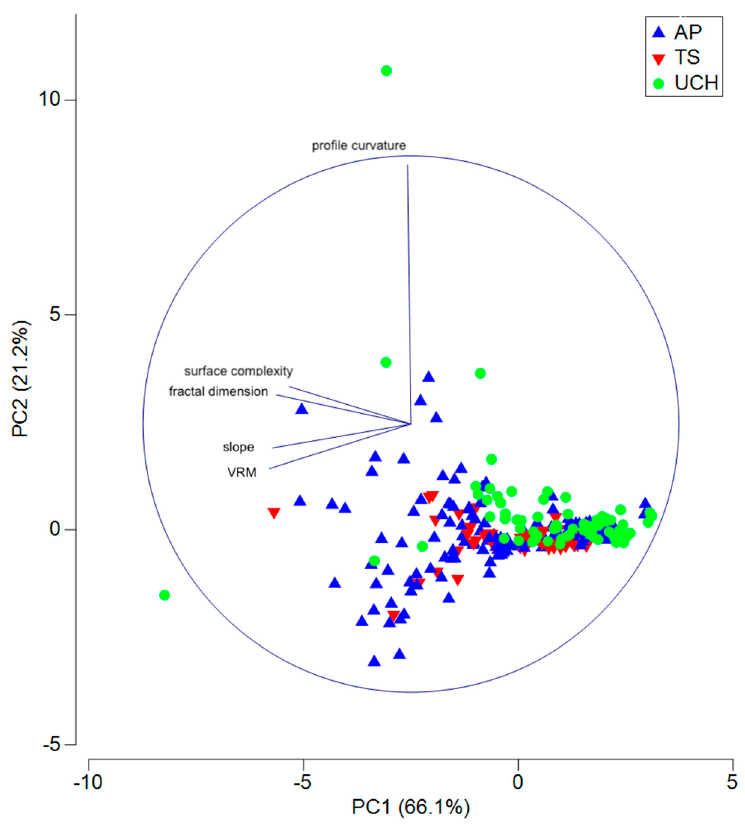
Figure 4. PCA analysis of variation in 3D metrics of structural complexity among all sites. PC1 accounts for 66.1% of the observed variability in 3D habitat complexity and PC2 accounts for 21.2%. The coefficients primarily contributing to the variance explained by PC1 are slope, VRM, fractal dimension, and surface complexity. Profile curvature was the primary contributor to the variance explained by PC2. Data are labeled by the three habitat categories: AP (natural protected reefs in Apra Harbor region), TS (natural exposed reefs in the Telecommunications region), and UCH (artificial reefs).